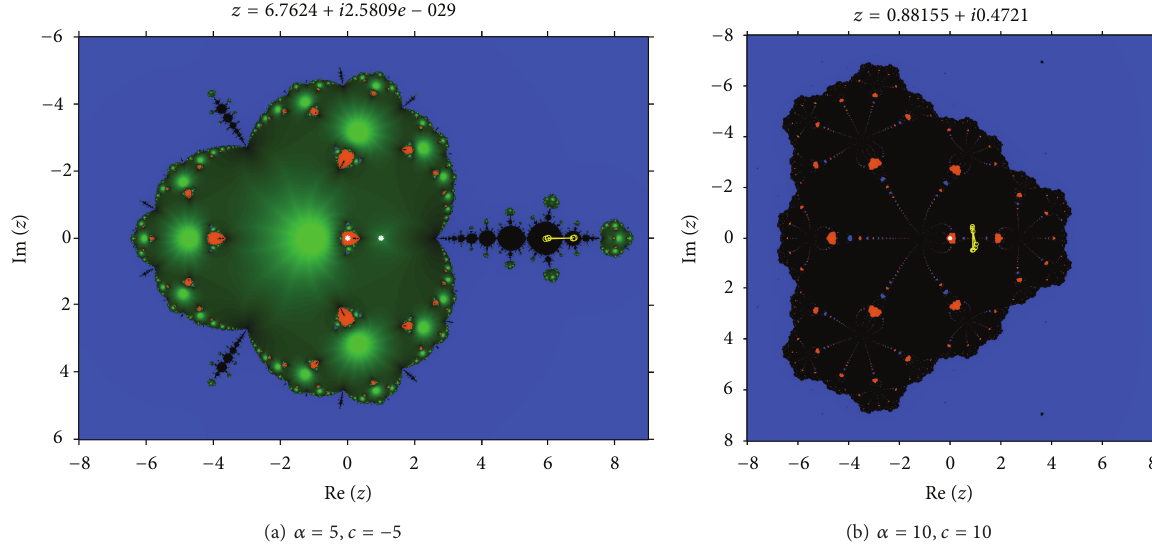
Figure 11: Unstable behavior: one 2-periodic orbit.